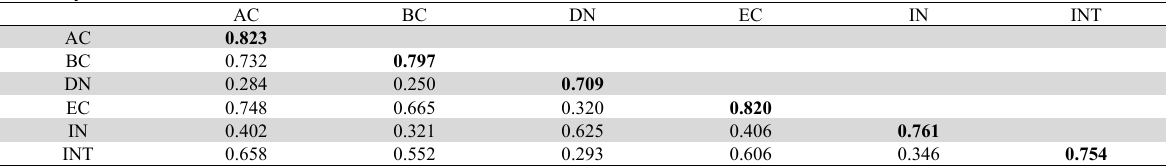
Summary of Fornell-Larcker